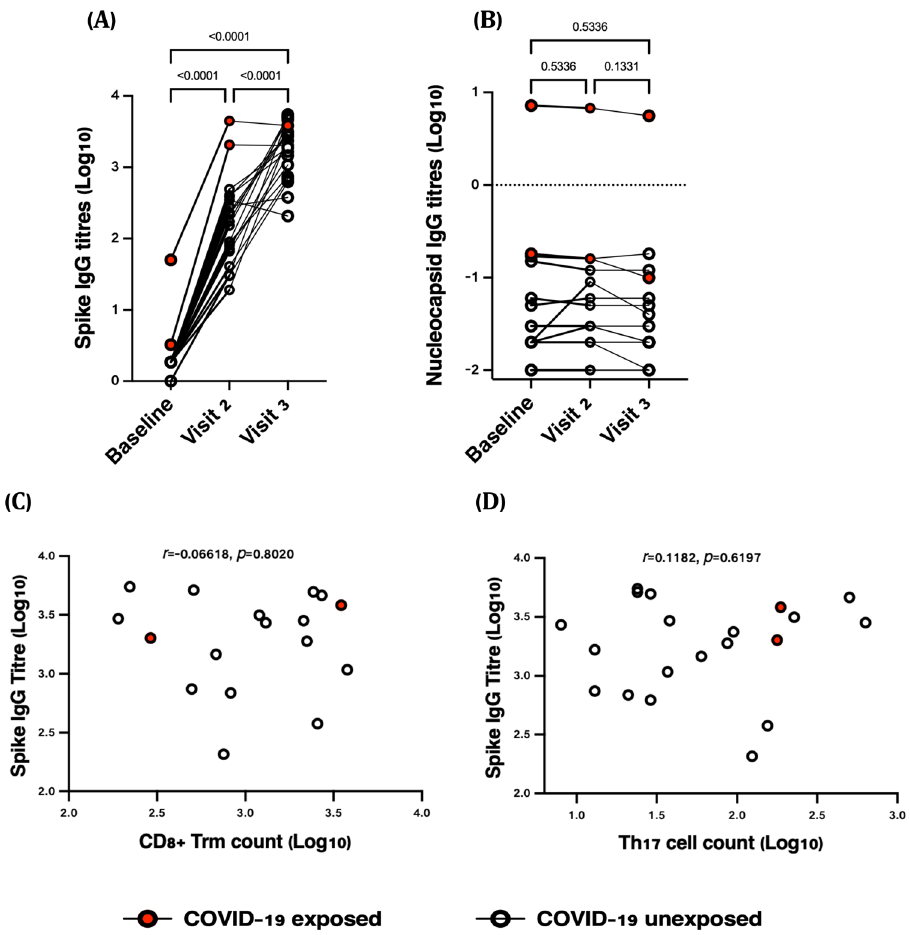
Fig. 6 Plasma IgG antibody titers following SARS-CoV-2 vaccination and correlations with nasal T cell responses ( n = 21). A Spike-speci fi c IgG titers increased signi fi cantly from baseline, visit 2 and visit 3 ( P < 0.0001) while B no differences were observed for nucleocapsid speci fi c IgG titers. C Correlation of nasal CD8 + Trm and D CD4 + CCR6 + CD161 + (Th17) T cell counts with spike antibody titers at visit 3, ~12 days following the second SARS-CoV-2 vaccine dose. Red dots indicate COVID-19 exposed participants while the white dots represent COVID-19 unexposed participants (Two-tailed non- parametric Spearman ’ s correlations